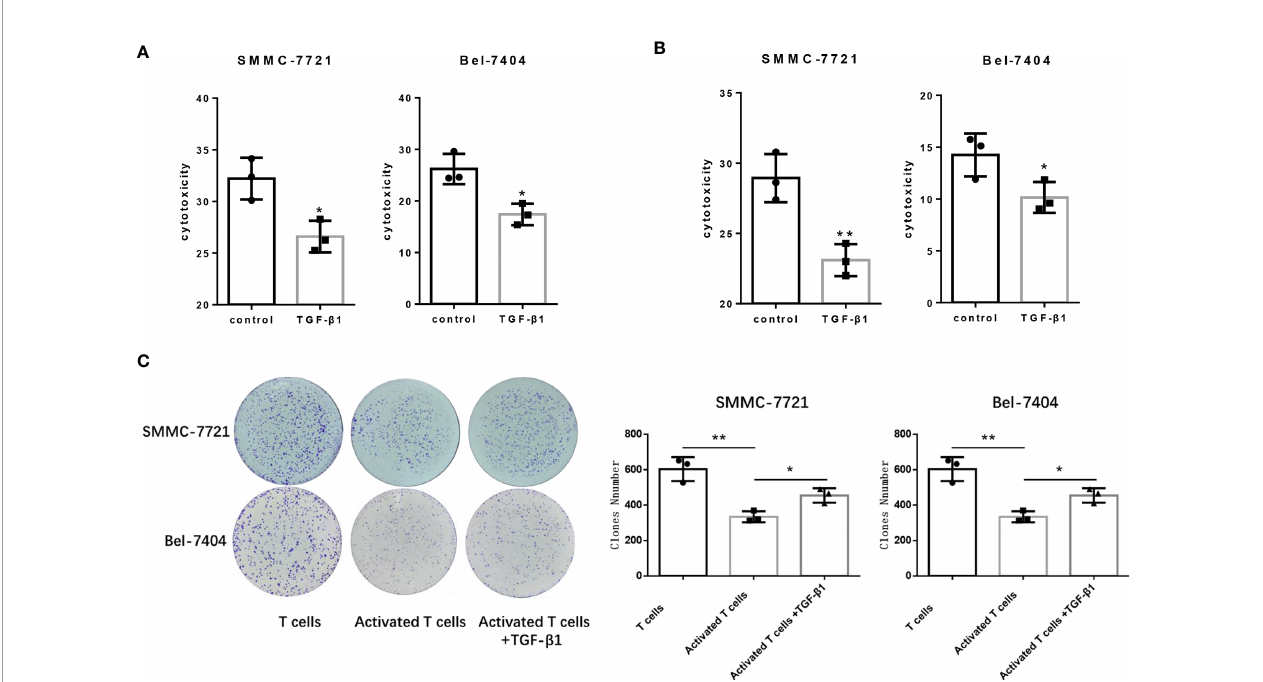
FIGURE 2 | TGF- b 1 attenuates the cytotoxicity of T cells for HCC cells. (A) Activated T cells stimulated or not stimulated with TGF- b 1 were co-cultured with SMMC- 7721 cells or Bel-7404 cells for 24 h. CCK-8 assay was used to determine the cytotoxicity of T cells for SMMC-7721 and Bel-7404 cells. (B) LDH cytotoxicity assay was used to determine the cytotoxicity of T cells for SMMC-7721 and Bel-7404 cells. (C) Colony formation assay was used to determine the cytotoxicity of T cells for SMMC-7721 and Bel-7404 cells. n = 3, *P < 0.05, **P < 0.01 vs. control